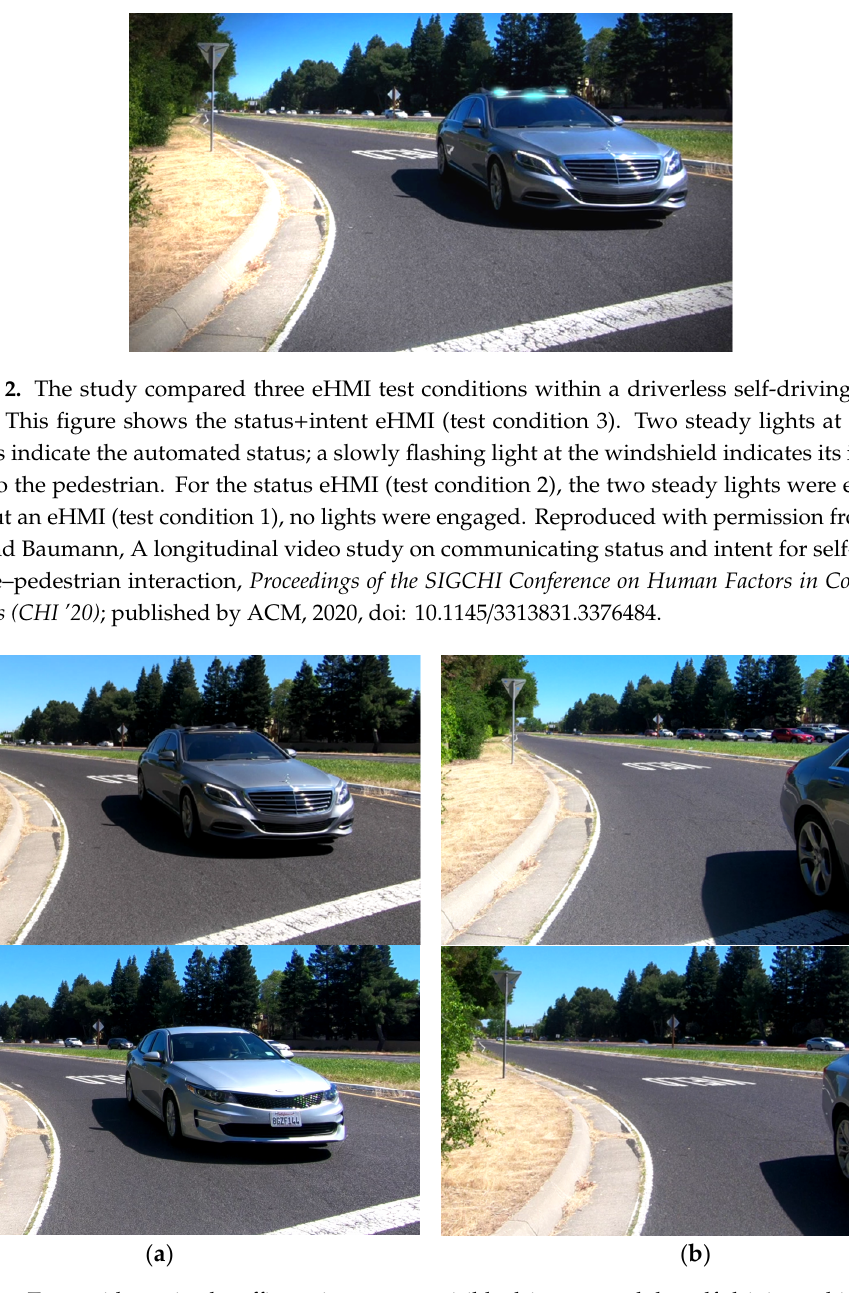
Figure 3. To provide a mixed-traffic environment, a visible driver steered the self-driving vehicle (SDV; top row) respectively a conventional vehicle (CV; bottom row). They were either ( a ) yielding to let the pedestrian cross first (test condition 4, 5); or ( b ) non-yielding (test condition 4b, 5b) so that the pedestrian has to wait for the vehicle to go first and crosses the empty street afterwards safely.